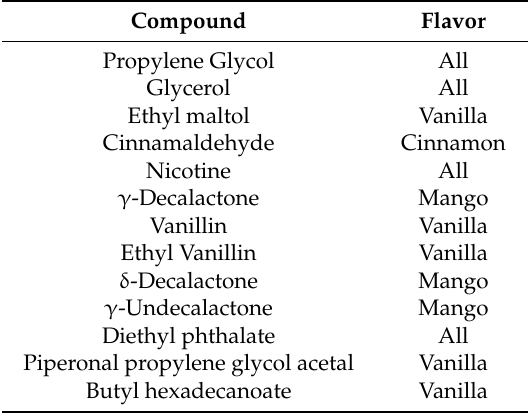
Table 5. Compounds observed in e-liquid, impinger, and filter pads.